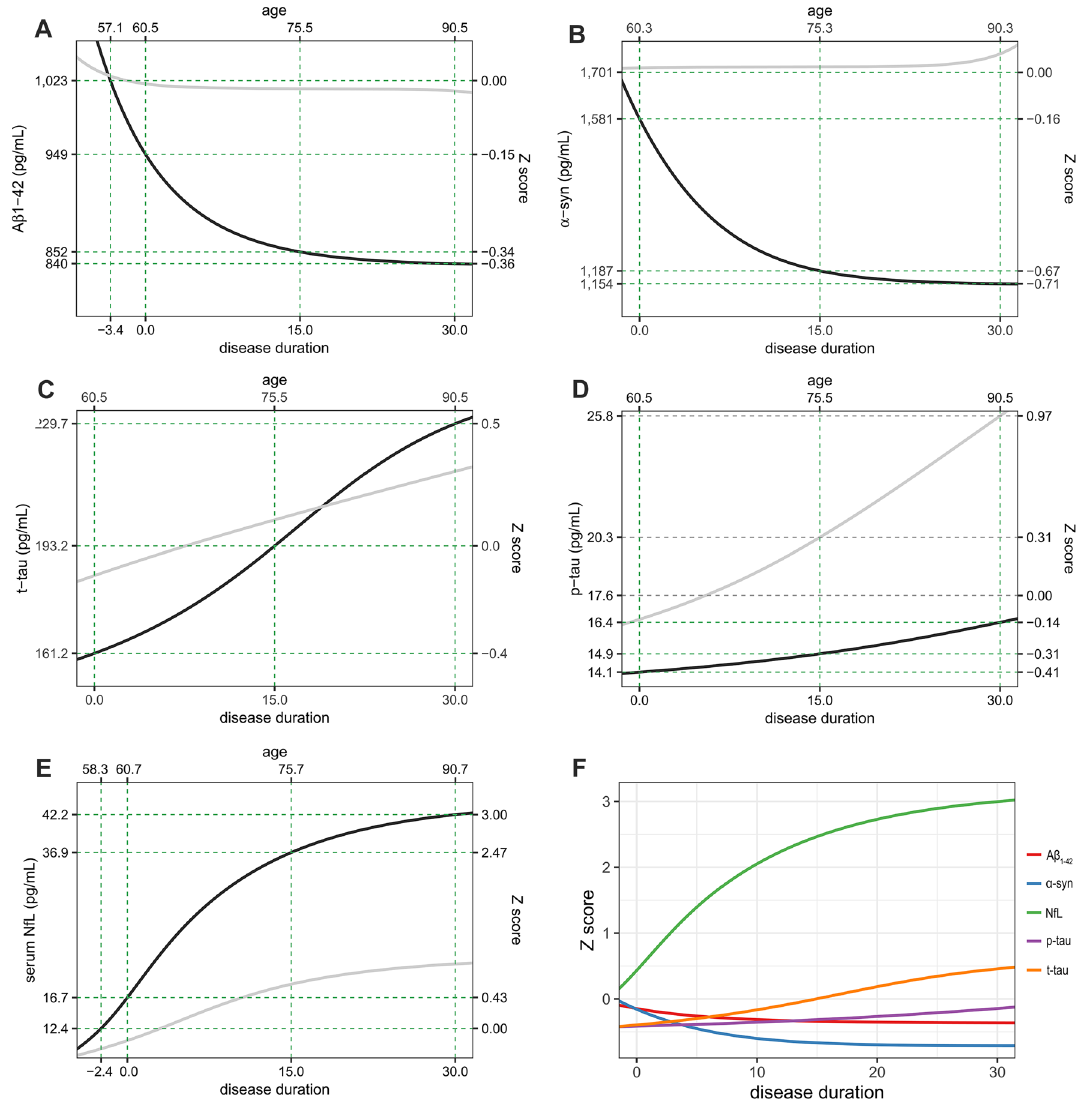
Figure 2. Estimated trajectories of biofluid markers in PD (black line) and control groups (gray line) as function of time. The temporal trajectories were acquired by modified Euler’s method for solving the first order differential equation. Temporal trajectories of CSF Aβ 1-42 and α-syn show negative exponential pattern with suspicious plateau ( A , B ), while those of the CSF t-tau and p-tau, and serum NfL show steady increase pattern ( D ) or sigmoid appearance ( C , E ). Z score change in serum NfL was the largest within biofluid markers ( F ). Figures are illustrated using ggplot2 and patchwork packages in R software. Aβ 1-42 amyloid-β 1-42 ; α-syn α-synuclein; t-tau total tau; p-tau phosphorylated tau; NfL neurofilament light